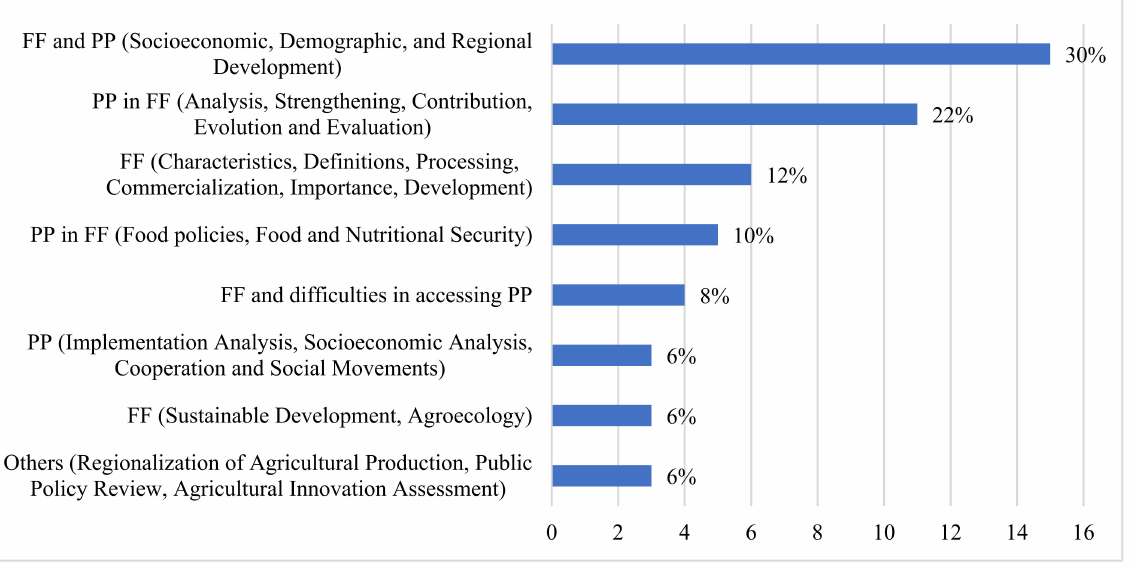
Figure 6. Focal themes of the articles. PP = public policy; FF = family farming. Source: research data